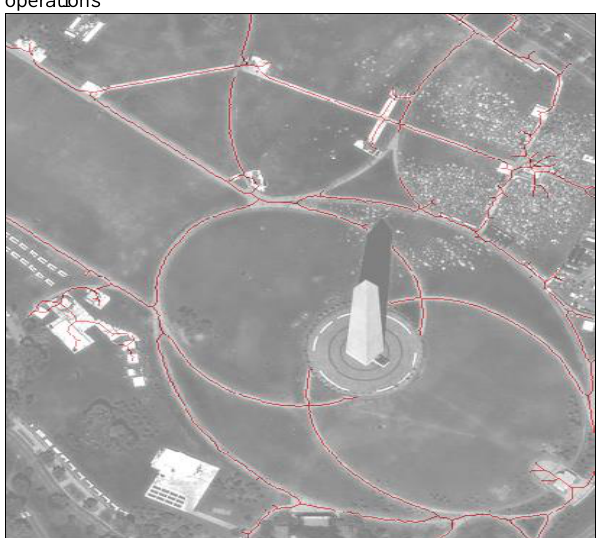
Figure 8. Detected road network